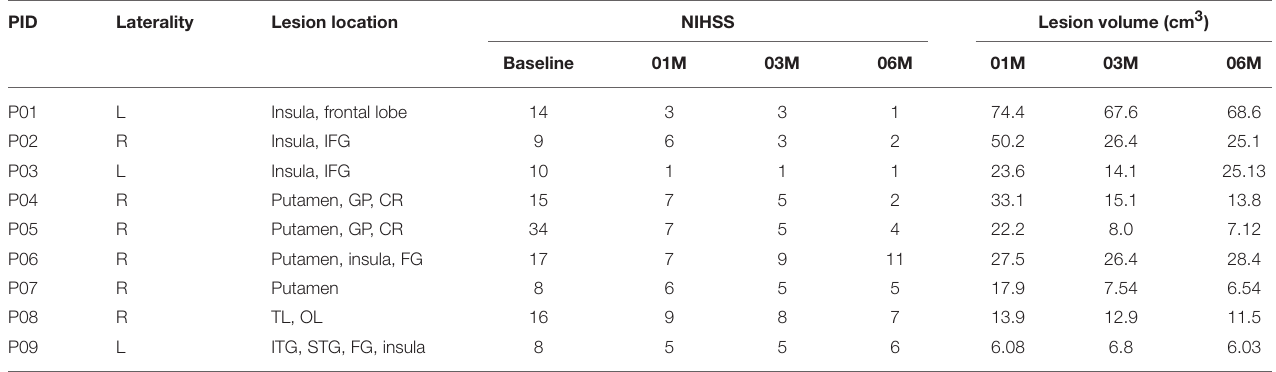
TABLE 1 | Patient demographics, clinical score, and lesion volume.